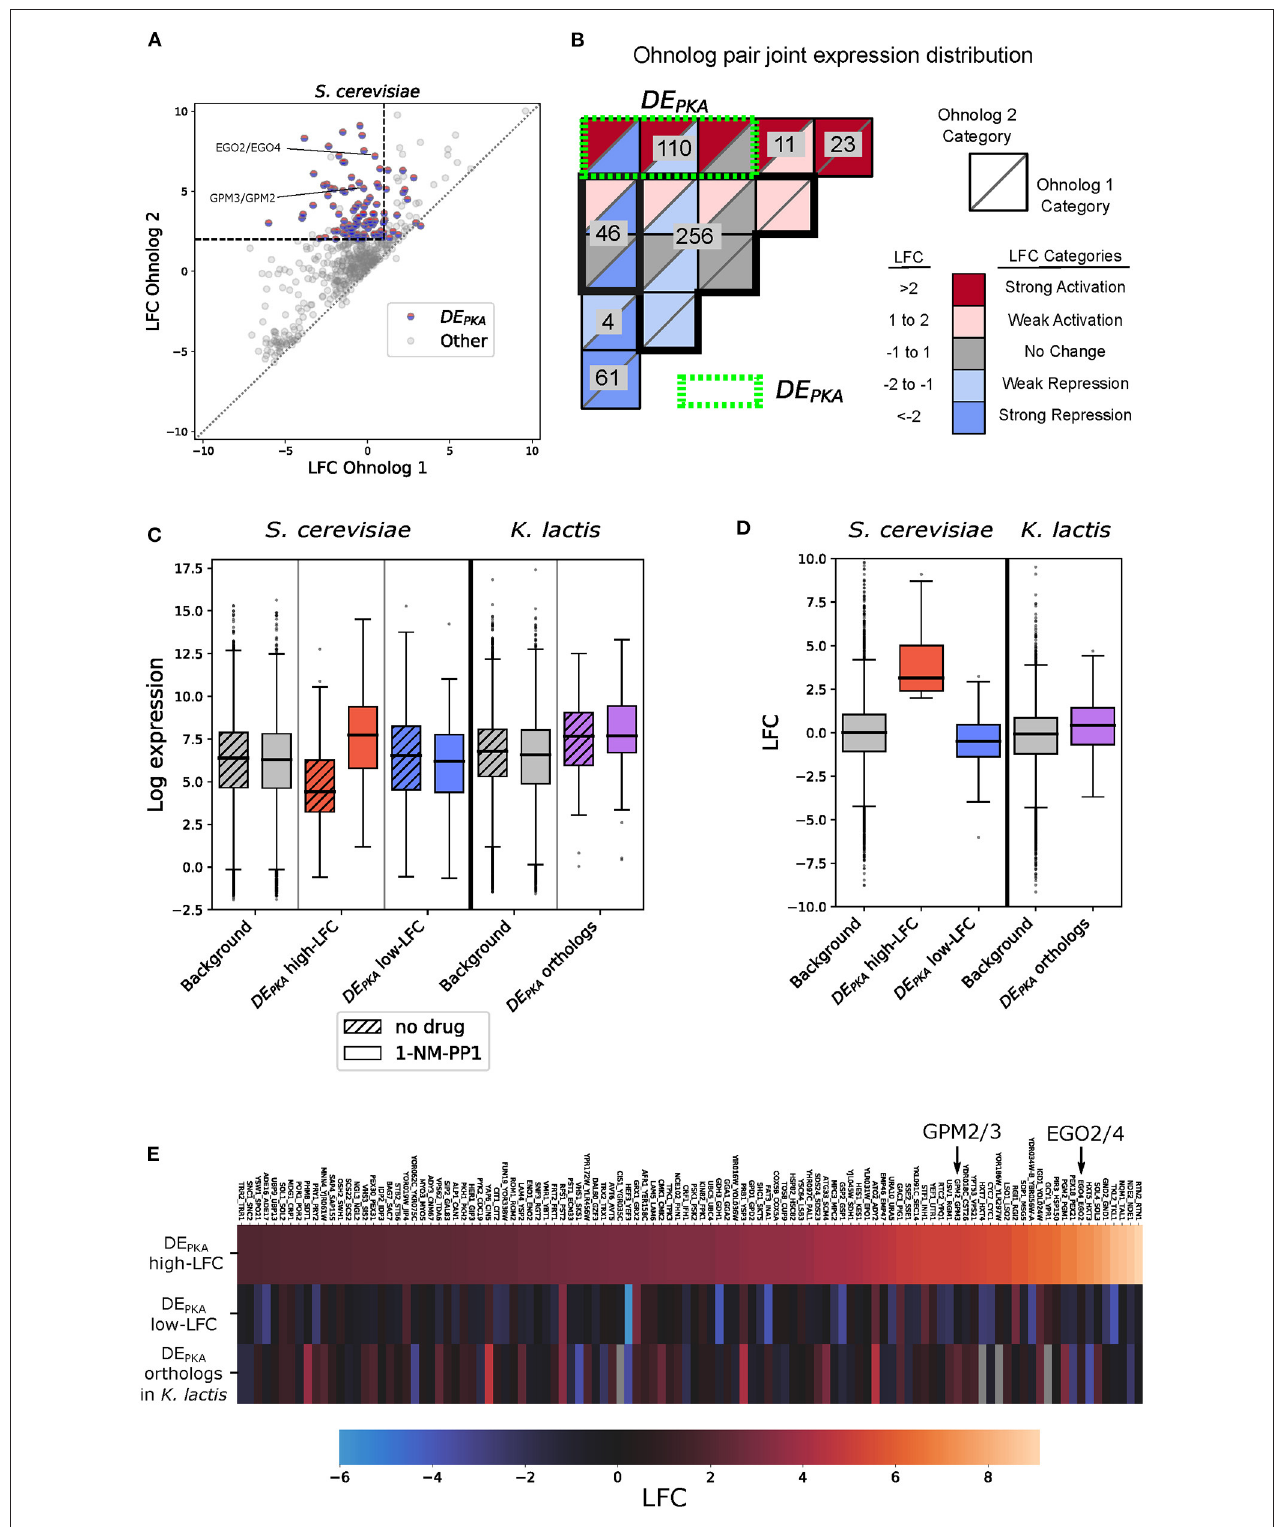
FIGURE 2 | One hundred ten ohnolog pairs show differential expression in response to PKA. One member of the pair is activated while the other is repressed or unaffected. The phenotypes of the shared orthologs from K. lactis on average resemble the ohnologs that are not activated by PKA inhibition. (A) Comparison of